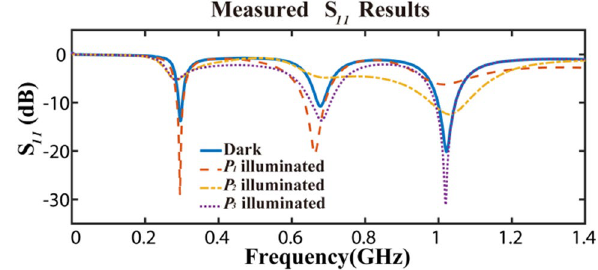
Figure 8. Measured results of S 11 parameters.